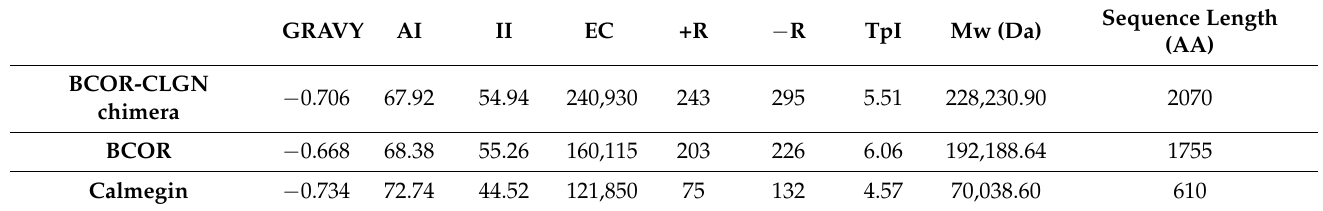
Table 1. The physicochemical characteristics of the wild-type and the fusion protein. GRAVY: grand average hydropathy, AI: aliphatic index, II: instability index, EC: extinction coefficient at 280nm, +R: the number of positively charged residues, − R: the number of negatively charged residues, TpI: the theoretical isoelectric point, Mw: molecular weight, AA: amino